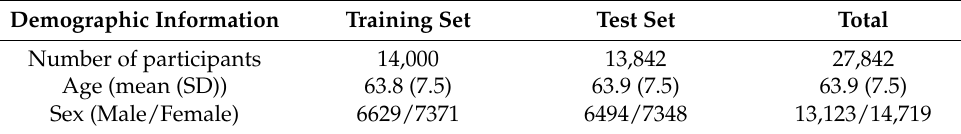
Figure 1. UKB participant inclusion chart. Table 1. Demographic information for participants included in the training and the test sets.